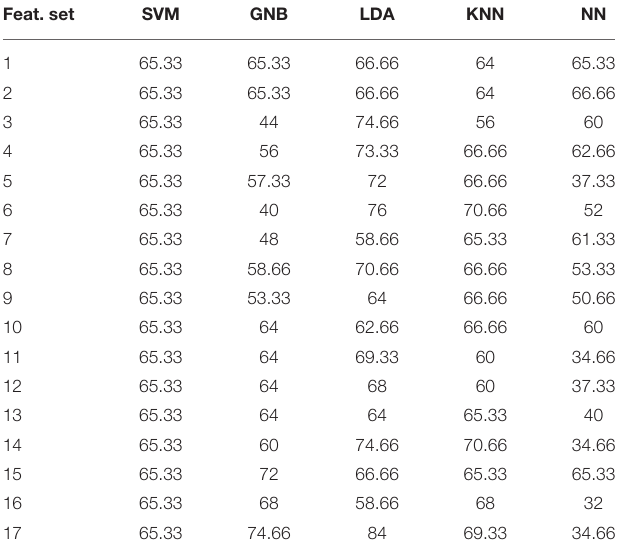
TABLE 7 | Performance of different models at different extracted features for voiced (V) modality obtained from AC channel. Feat. set